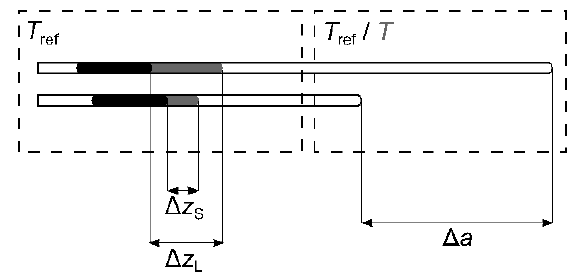
Fig. 1. Illustration of the dual-capillary method principle (rotated 90 ° counterclockwise compared to the position of capillaries in the